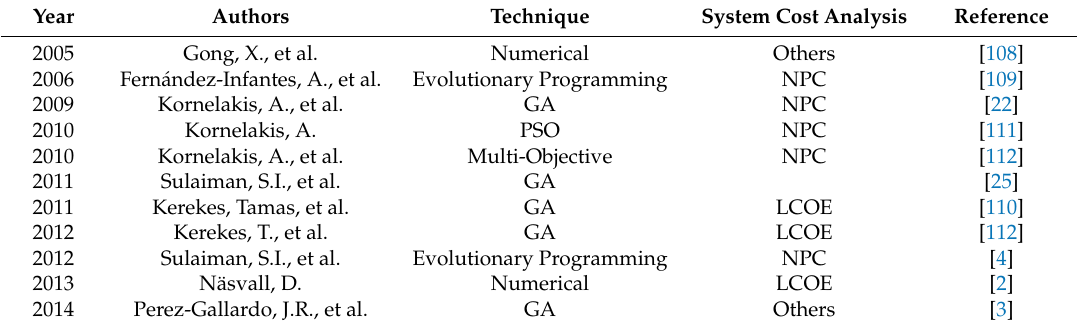
Table 3. Summary of GCPV optimal sizing methods.